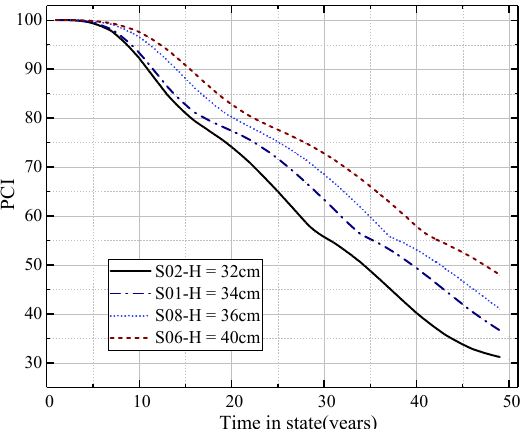
Figure 8. Prediction of PCI for the model with different pavement thicknesses.